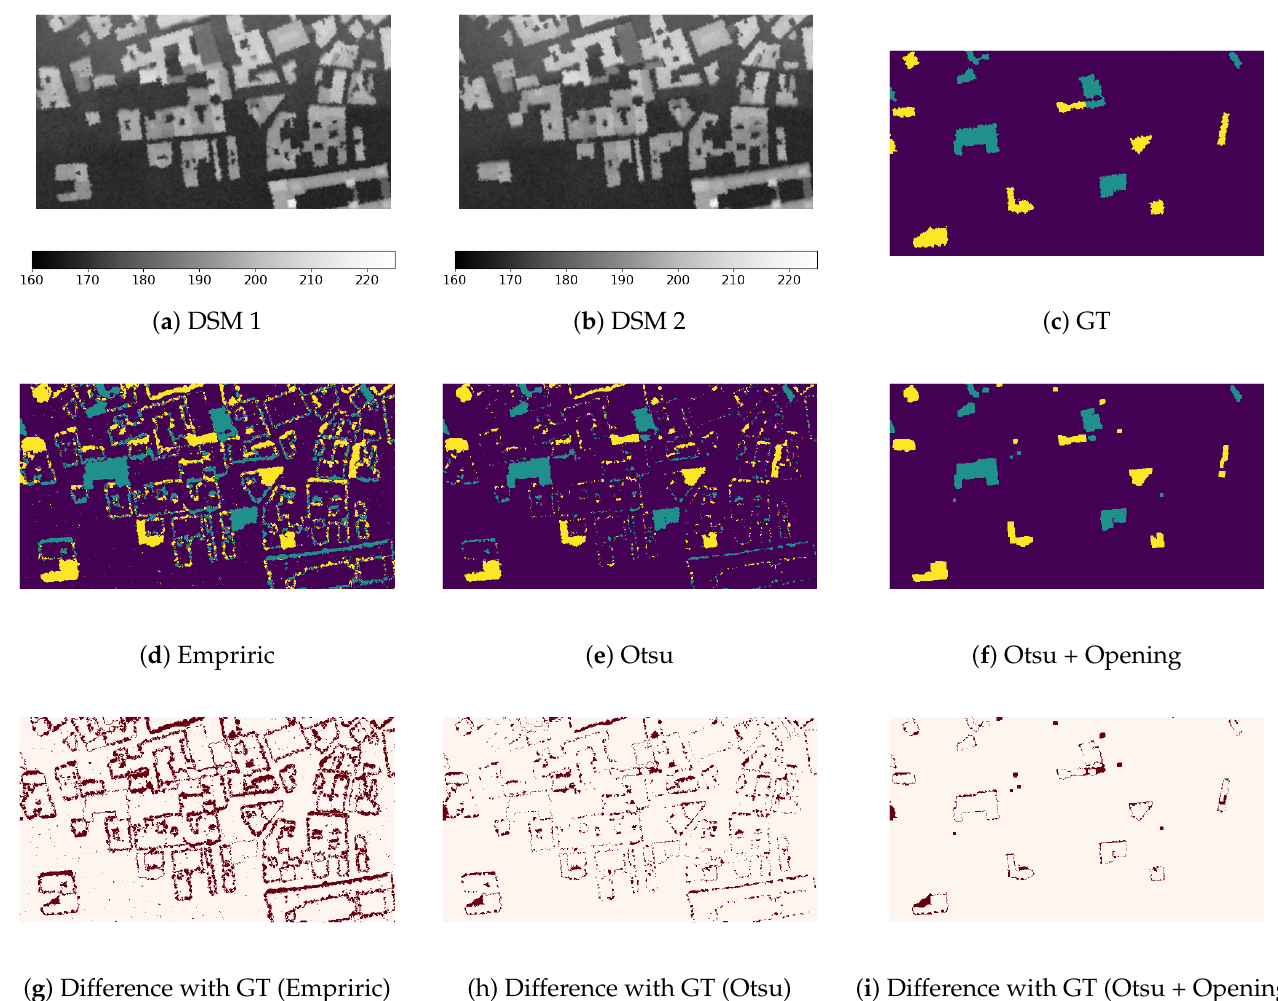
Figure 10. Results at the 2D pixel level for sub-dataset 4 (photogrammetric). ( a , b ) DSMs with their elevation levels in meters and ( c ) ground truth (GT) with the following color code: purple for unchanged parts, blue for newly built parts and yellow for demolished parts. Results of DSMd with empirical thresholding ( d ), thresholds from the Otsu algorithm ( e ) and post-processing with an opening filter ( f ). Respective errors maps ( g – i ) highlight the differences (in red) from the ground